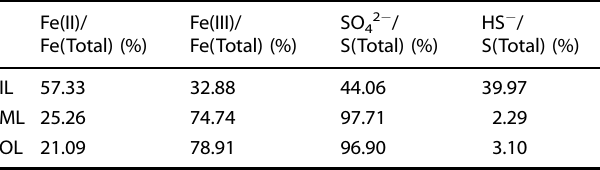
Table 2. Substance content in each valence state by narrow-scan XPS fi tting (%). Fe(II)/ Fe(III)/ Fe(Total) (%) Fe(Total)